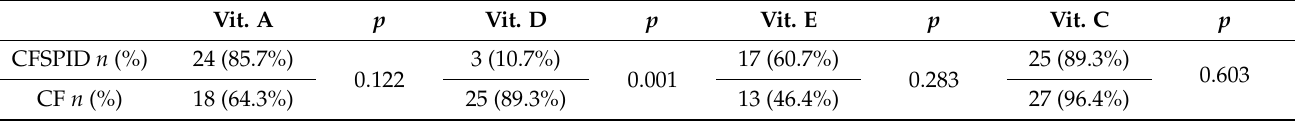
Table 6. Adherence to recommendations for daily vitamin intake in CFSPID and CF groups.